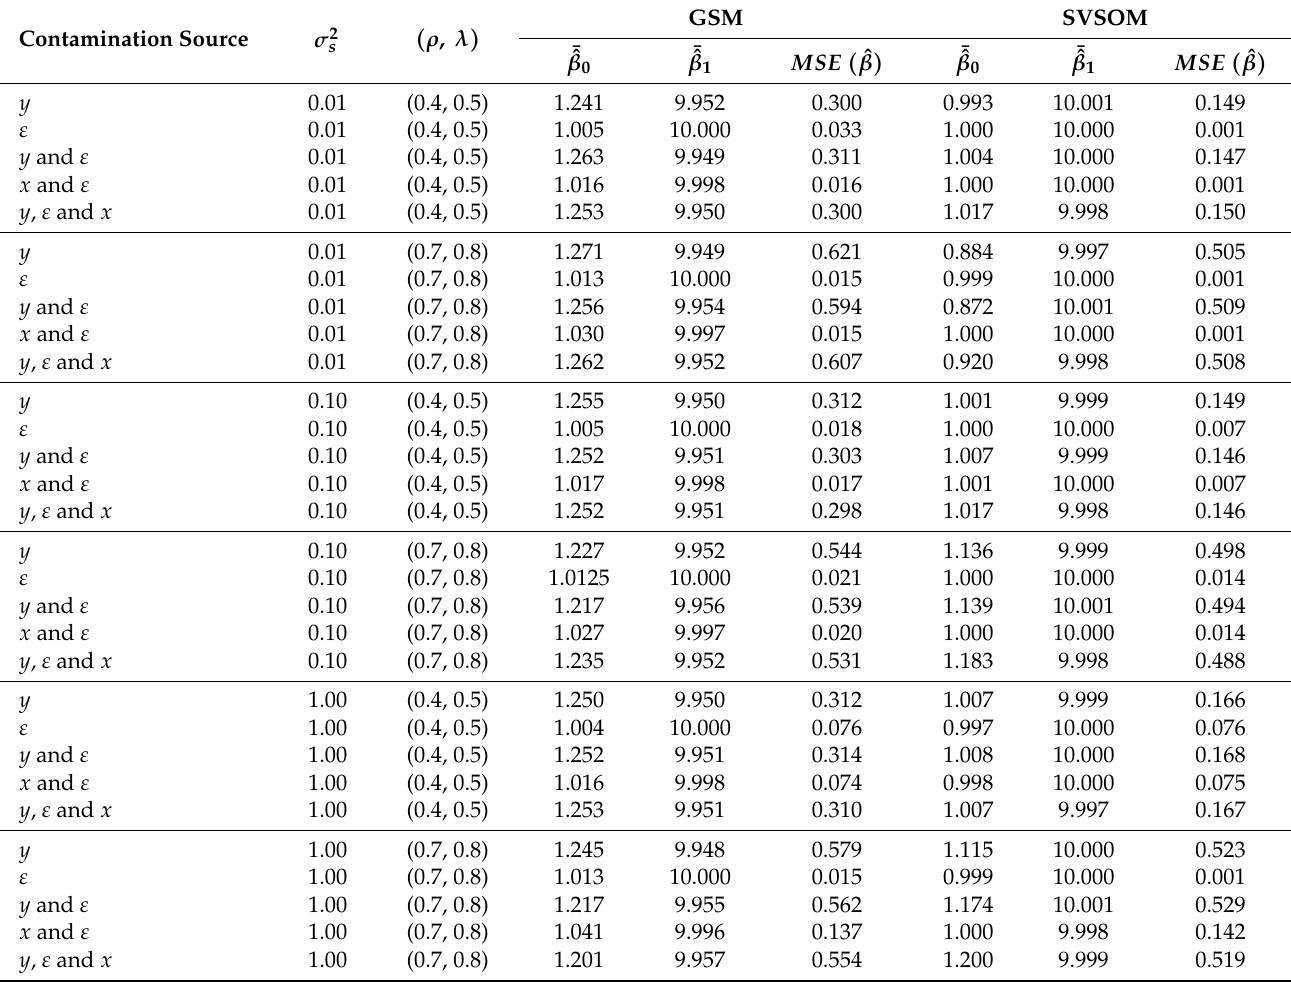
Table 1. The estimates of β 0 , β 1 and MSE ( ˆ β ) in the GSM and